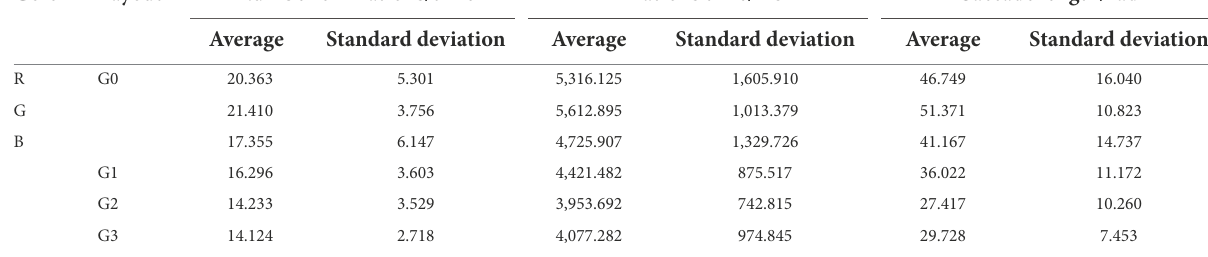
TABLE 8 Eye movement data for six experimental conditions.